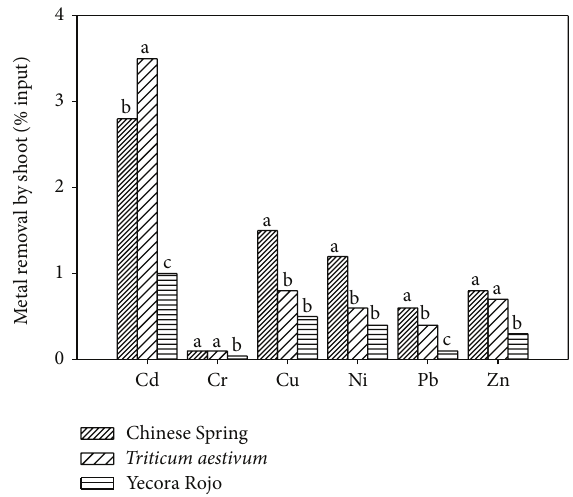
Figure 2: Metal removal by shoots of three wheat cultivars grown on sand media amended with biosolids for 12 weeks (the differences of metal removal among the wheat cultivars were tested by one- way ANOVA test and values followed by same lower letter were not significant different at 𝑃 < 0.05